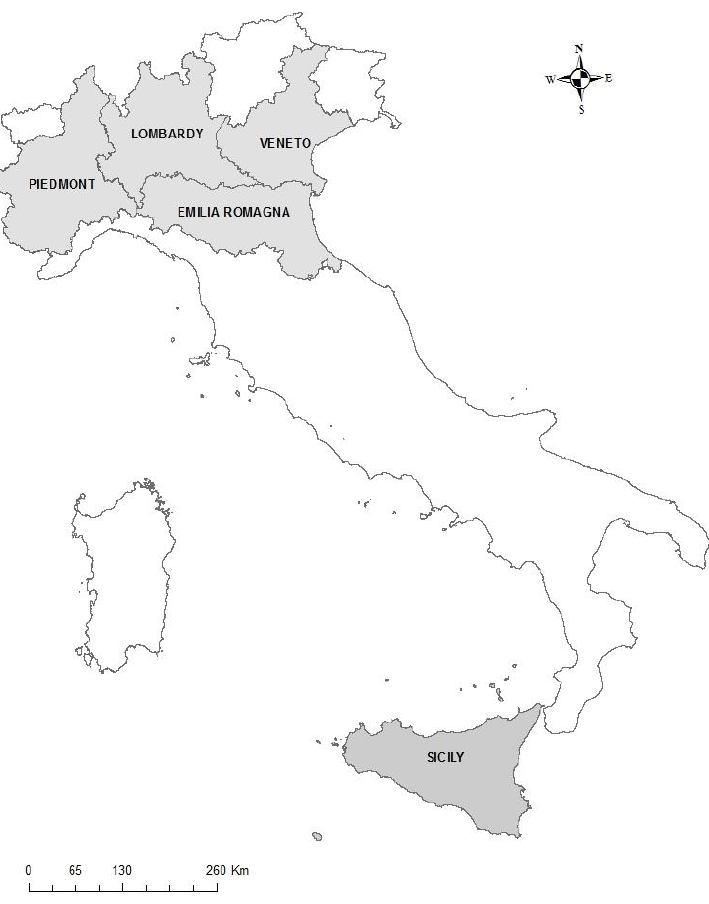
Figure 1. Location of the Italian Regions of Lombardy, Emilia-Romagna, Piedmont, Veneto and Sicily.